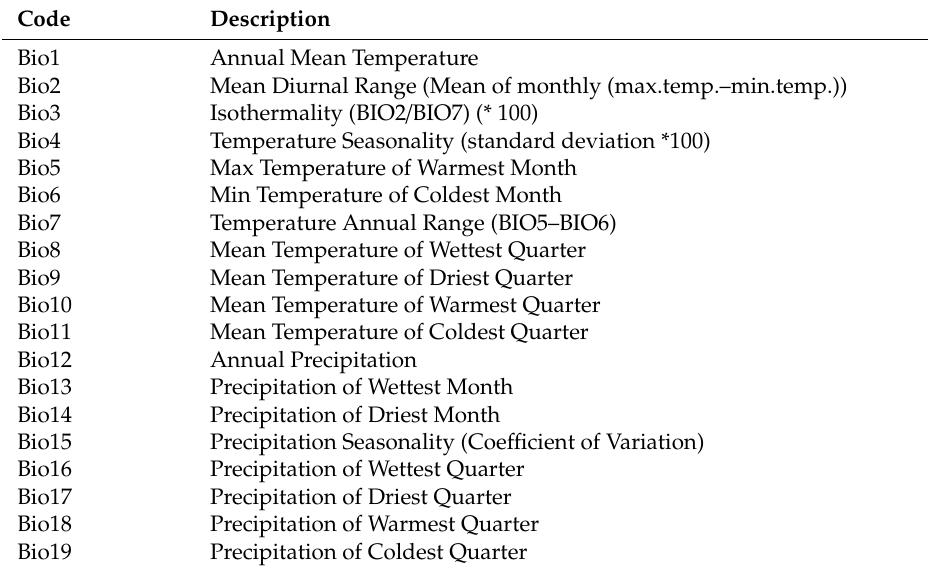
Table 4. 19 bioclimatic variables used to build the